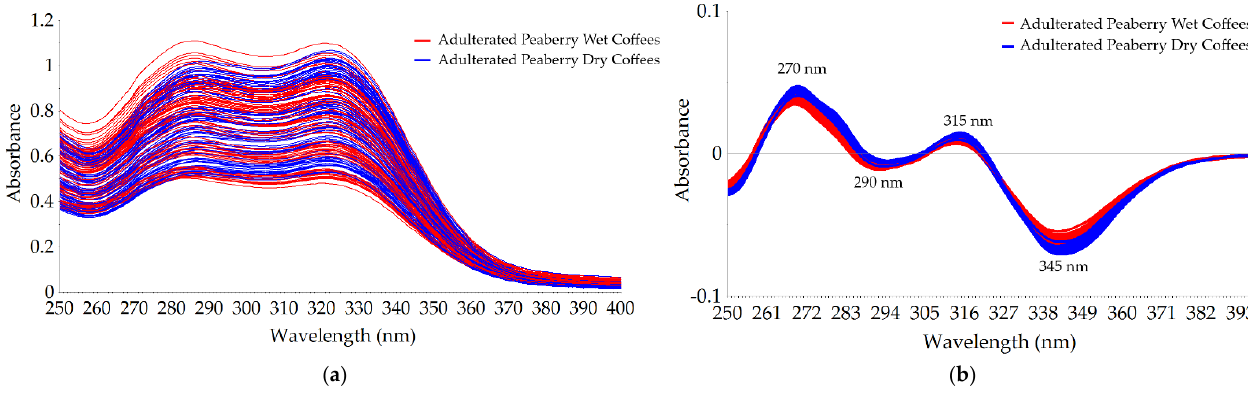
Figure 2. Spectral data of peaberry wet and dry-processed coffee with 10–50% of corn adulteration in the range between 250 and 400 nm: ( a ) raw spectra; ( b ) pre-processed spectra (MAS + SNV + SG1d).